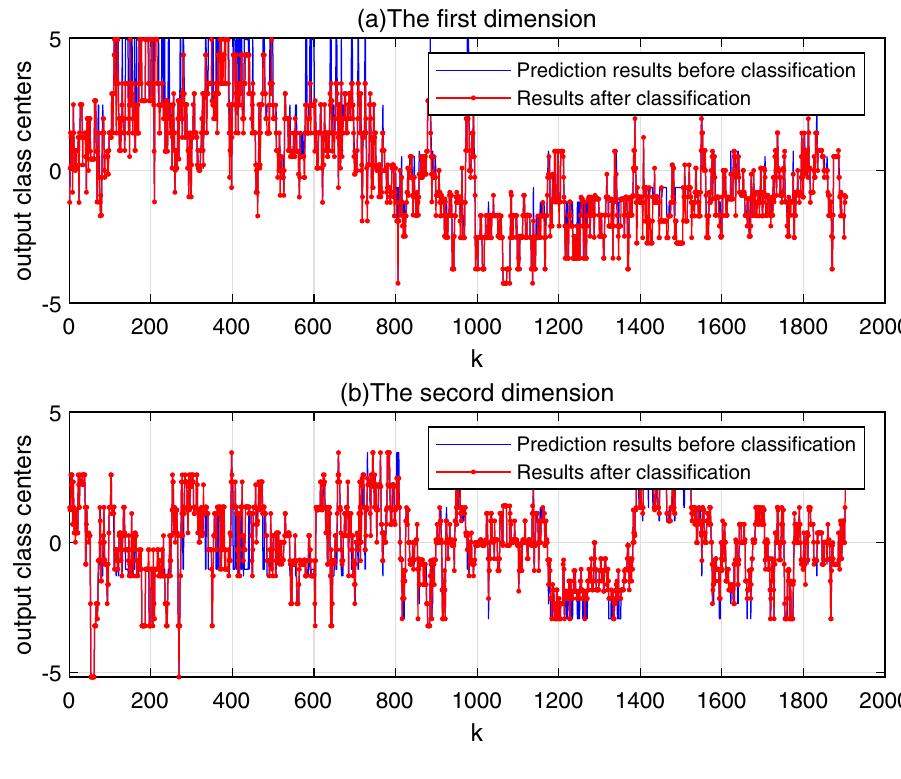
Fig. 7 Comparison of predic- tion models before and after